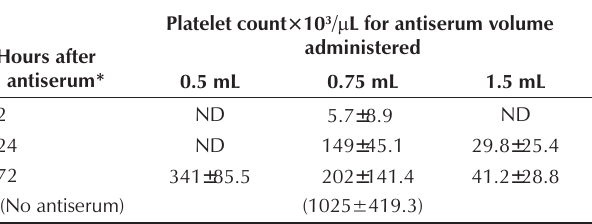
TABLE 1 Platelet counts in rats: Effect of antithrombocyte treatment Platelet count×10 3 / (cid:2) L for antiserum volume Hours after antiserum*